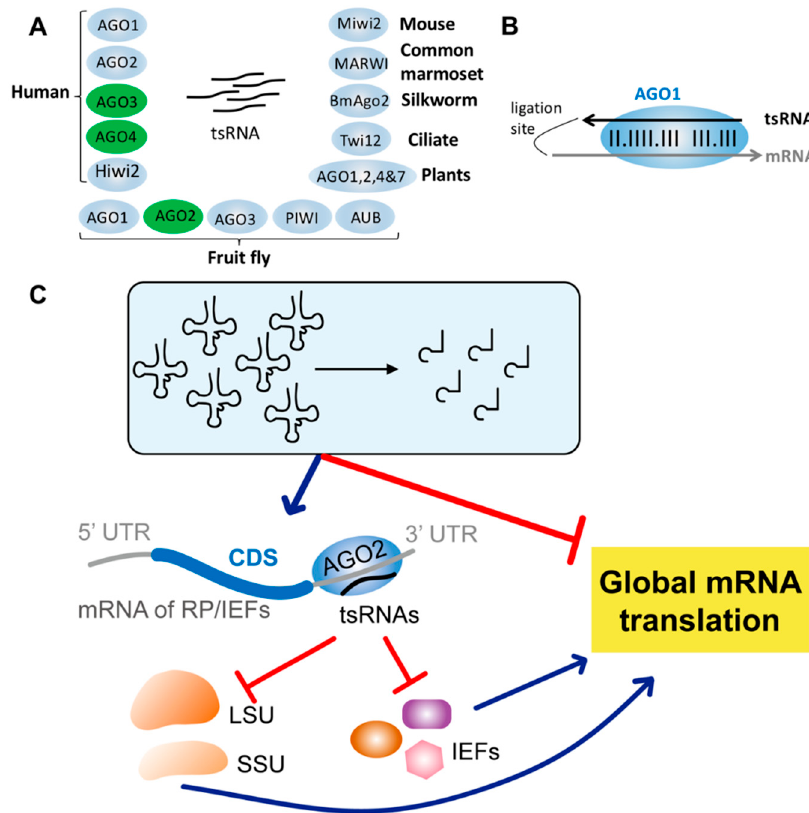
Figure 3. AGO-dependent tsRNA-mediated regulation. ( A ) tsRNAs are bound by AGO proteins in various species. In humans, tsRNAs are preferentially associated with AGO3 and 4 over AGO1 and 2 [68], and tsRNAs are also bound by Hiwi2 [65]. In Drosophila , tsRNAs are bound by AGO1, AGO2, AGO3, PIWI, and AUB. In S2 cells, tsRNAs are preferentially bound by AGO2 over AGO1 [23]. tsRNAs are also bound by Miwi2 in mice [65], by MARWI in the common marmoset [66], by BmAgo2 in silkworms [64], by Twi12 in ciliates [61,62], and by AGO1, 2, 4 and 7 in plants [63]. ( B ) The tsRNA-mRNA chimeras that are bound by AGO1 as revealed by human cross-linking, ligation and sequencing of hybrids (CLASH) data. ( C ) Drosophila tsRNAs suppress global translation by impeding ribosome biogenesis. Drosophila AGO2-bound tsRNAs preferentially inhibit translation of mRNAs of the ribosome proteins (RPs) or translational initiation or elongation factors (IEFs) through a RNAi-like approach, leading to attenuated global translation. Meanwhile, the processing of tRNA into tsRNAs also inhibits global translation since the abundance of tRNAs is reduced.